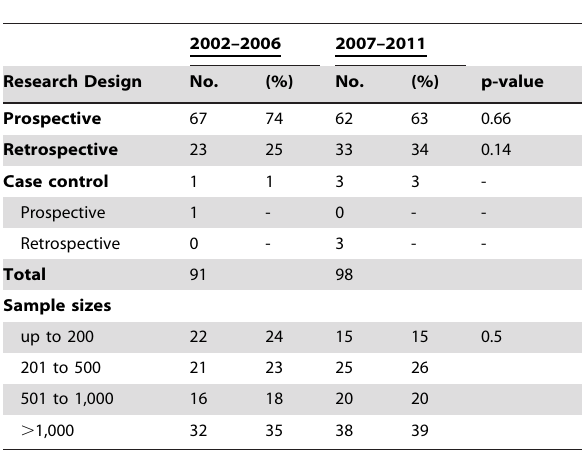
Table 2. Types of study designs and sample sizes.